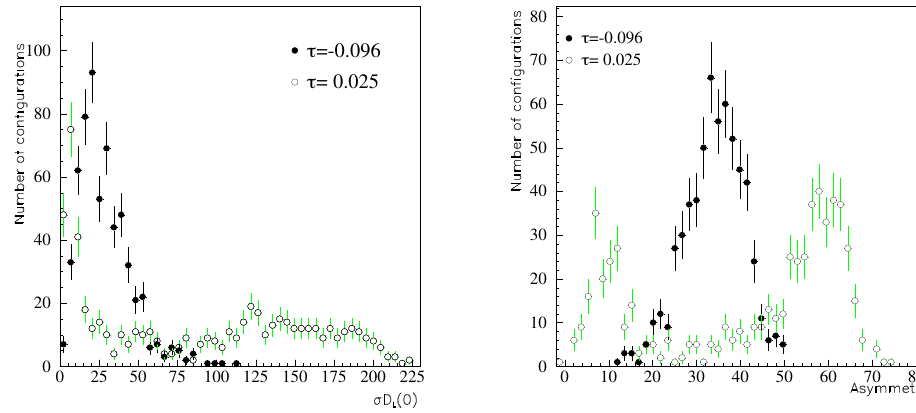
It is convenient to begin the analysis of the critical behavior of the longitudinal D L ( p ) and transverse D T ( p ) propagators by considering the temperature dependence of the distributions of gauge-field configurations in D L